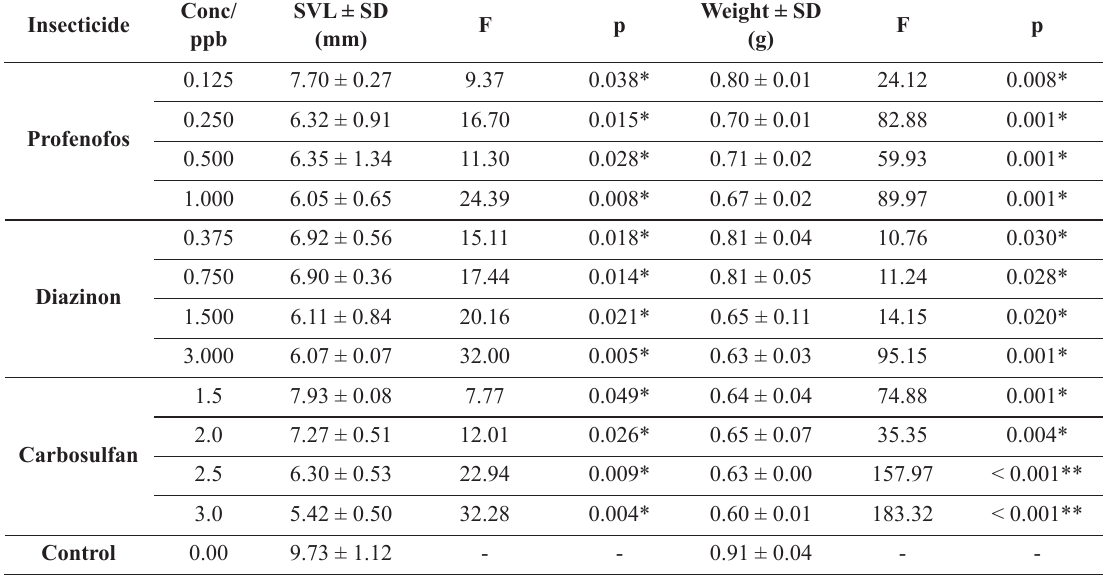
Table 3: Mean Snout-to-vent length (SVL) and mean weight at metamorphosis exposed to field concentrations of pesticides compared to the control using one-way ANOVA.